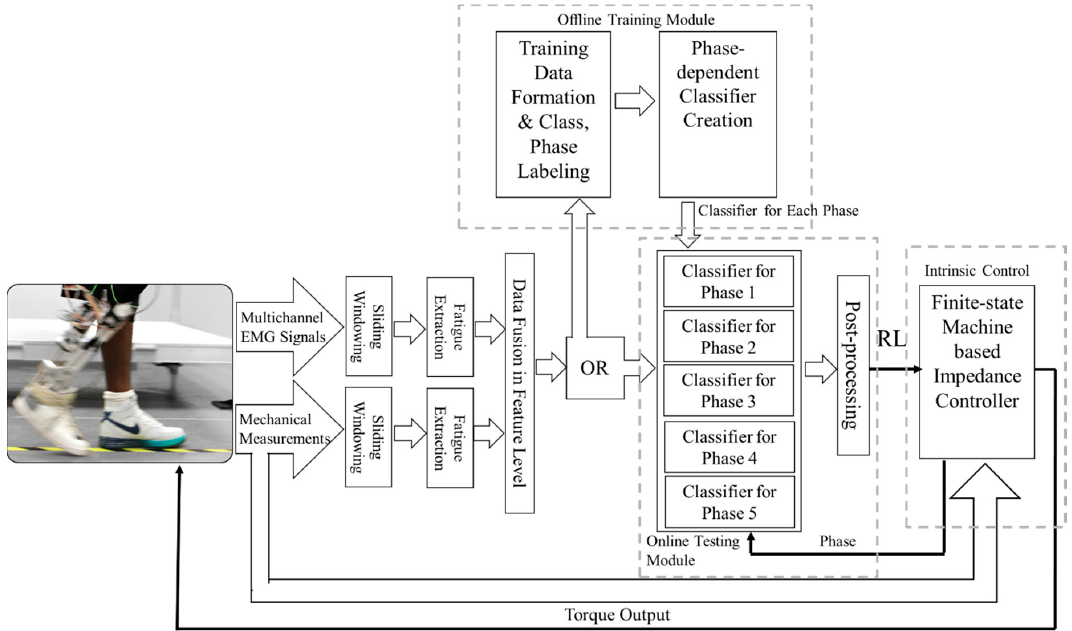
Figure 2. The locomotion recognition system used for lower limb prosthesis control. RL: recognized locomotion model.